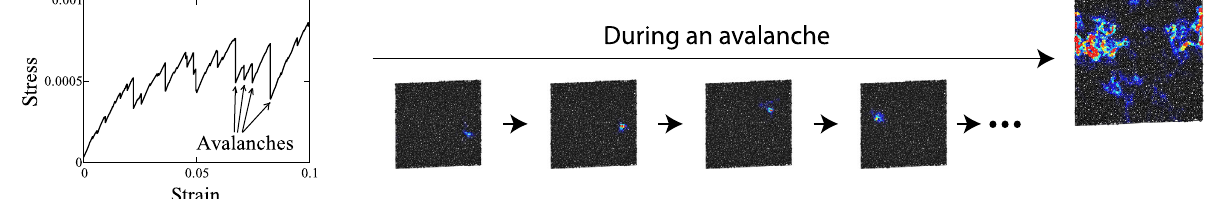
FIG. 2. As strain increases, avalanches occur during stress drops. During an avalanche, some constituent particles rearrange, triggering other localized rearrangements far away in the depicted system of N ¼ 4000 particles. Here, the nonaffine displacement D 2 particles is represented on a black-to-blue-to-red scale with red corresponding to high values of D 2 measured over the entire stress cumulative D 2 min